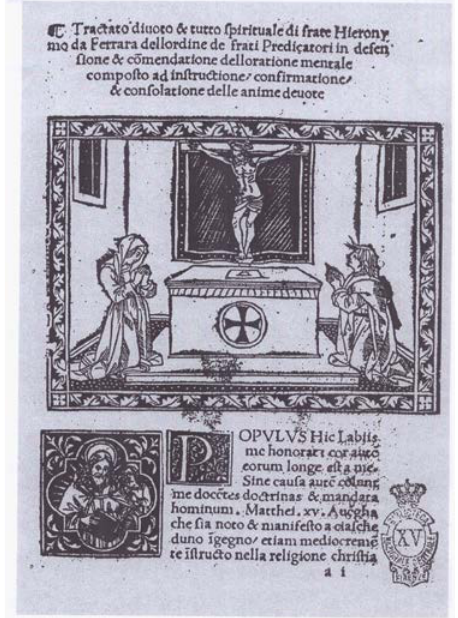
Figure 3 – Girolamo Savonarola, Tractato dell’oratione mentale , s.n.t. [but Firenze, Lorenzo Morgiani and Giovanni Petri, around 1495), f. 1r (BNCF, Cust C 23). By permission of Ministero per i beni e le attività culturali / Biblioteca Nazionale Centrale.